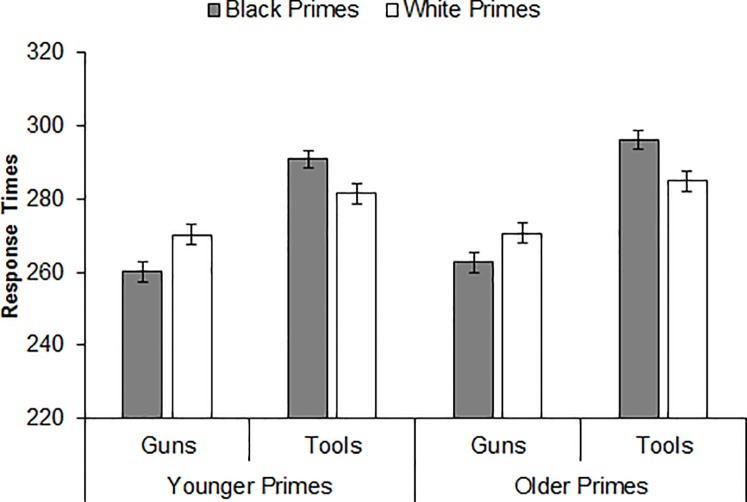
Mean response times (in milliseconds) for gun and tool identifications by prime race and prime age (Experiment 1).